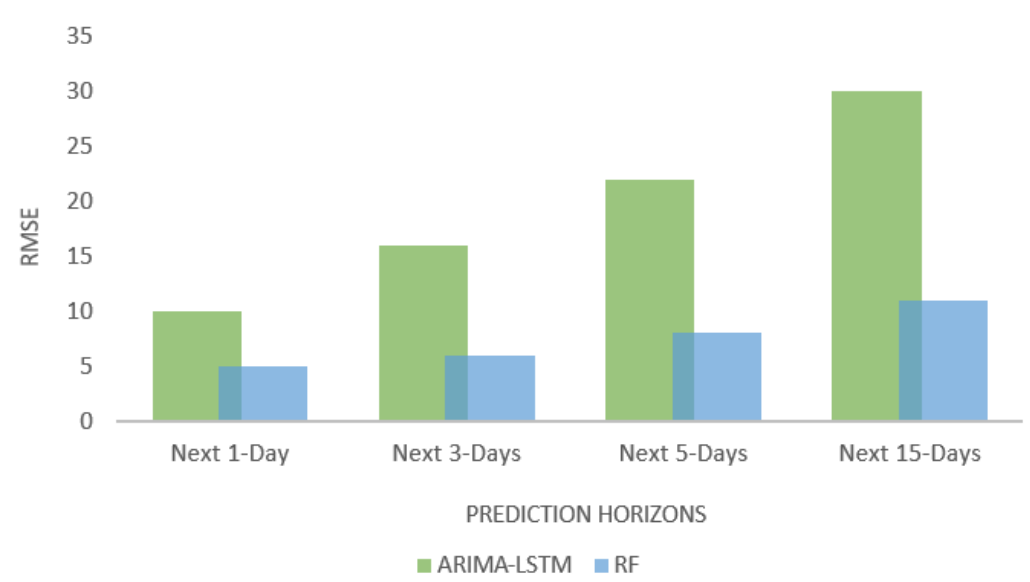
Figure 19. Comparison of the performance of ensemble models.